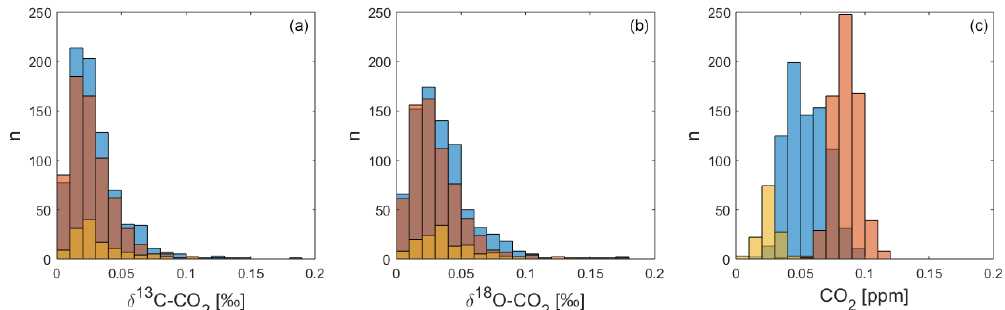
Figure 10. Internal reproducibility as the standard deviation (1 σ ) of the QC gas block averages in each sequence for δ 13 C-CO 2 (a) , δ 18 O- CO 2 (b) and CO 2 mole fractions (c) , with outliers excluded. QC-1 in blue, QC-2 in red and QC-3 in